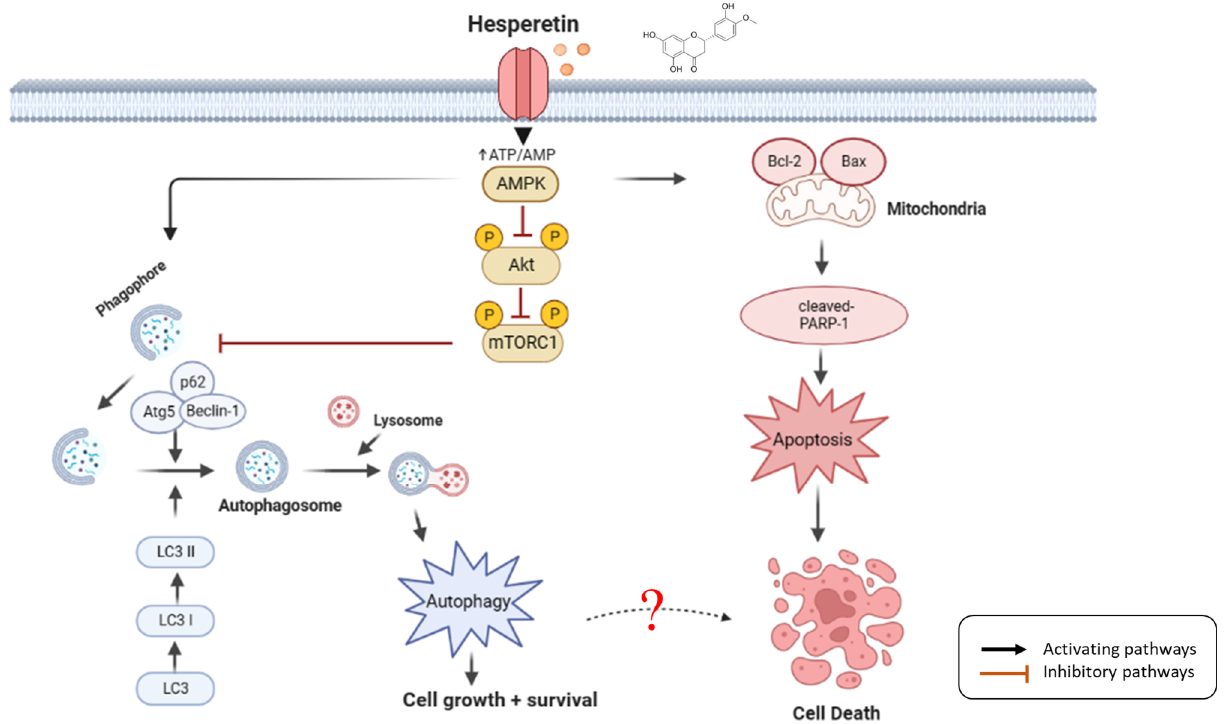
Figure 5. Schematic diagram of hesperetin molecular mechanism in leukemia cells. Hesperetin modulates AMPK/Akt/mTOR signaling and induces autophagy and delayed apoptosis by regulating the AMPK/Akt/mTOR pathway through AMPK activation, Akt and mTOR downregulation, inactivating and activating various target proteins, such as cleaved-PARP-1, Bcl-2, Bax, LC3-I/II, Beclin-1, Atg5, and p62; hesperetin promoted cell death in the human leukemic cell line U937 by inducing a low degree of slight apoptosis, cell cycle arrest, and autophagy, which increases the anticancer effect on leukemia (created with BioRender.com).